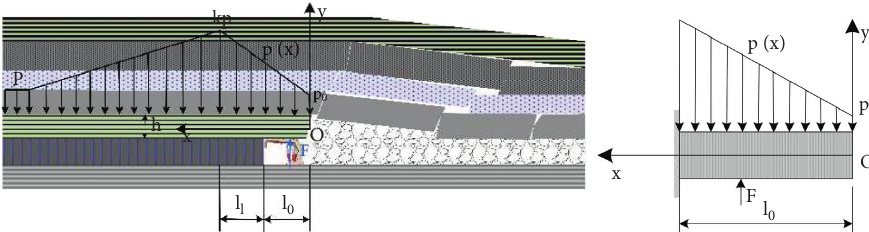
Figure 2: Mechanical model of the force distribution on the